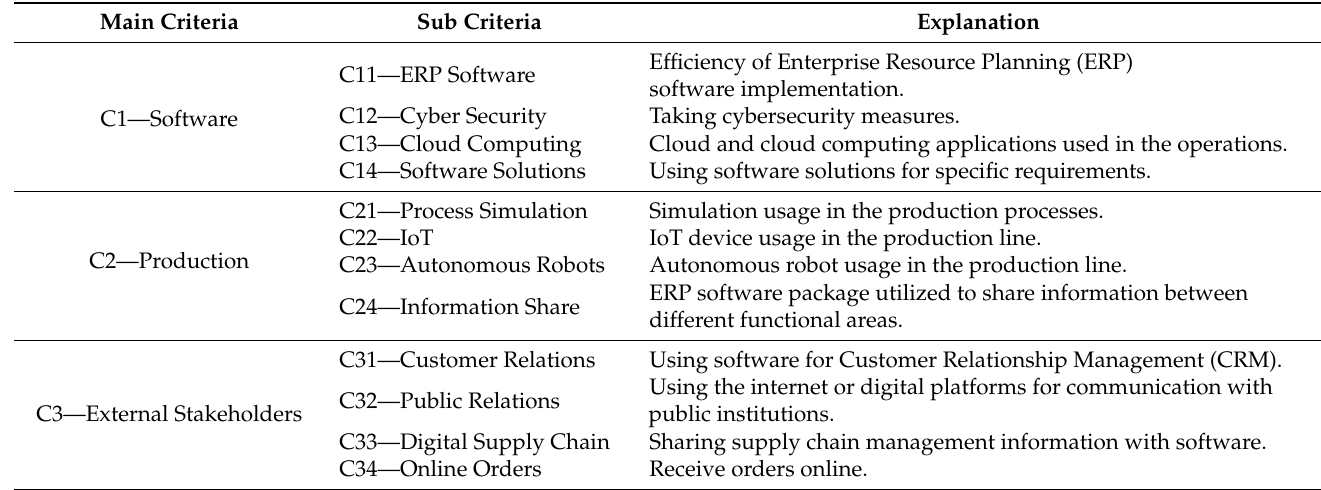
Table 3. The hierarchical structure of the proposed model.